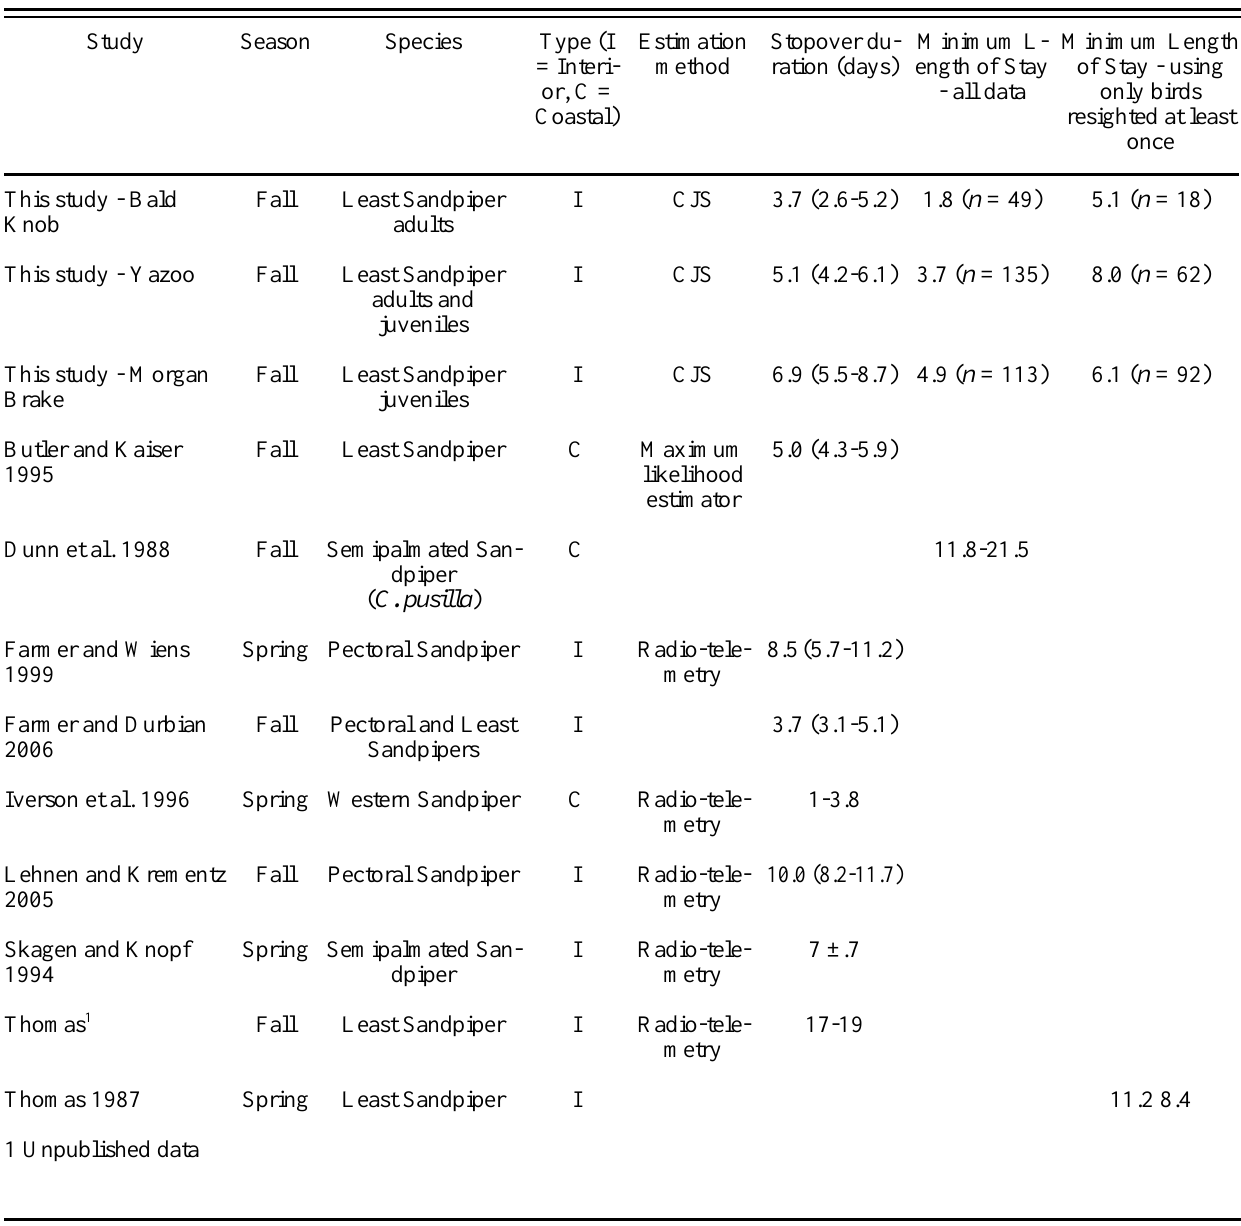
Table 3. Stopover duration estimates for Least Sandpipers in this study and comparison of estimates for other Calidris